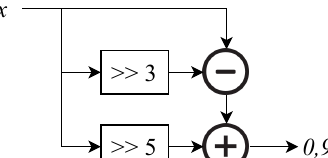
Figure 6. Example of a shift-and-add graph to implement a non-trivial multiplication by 0.90625.